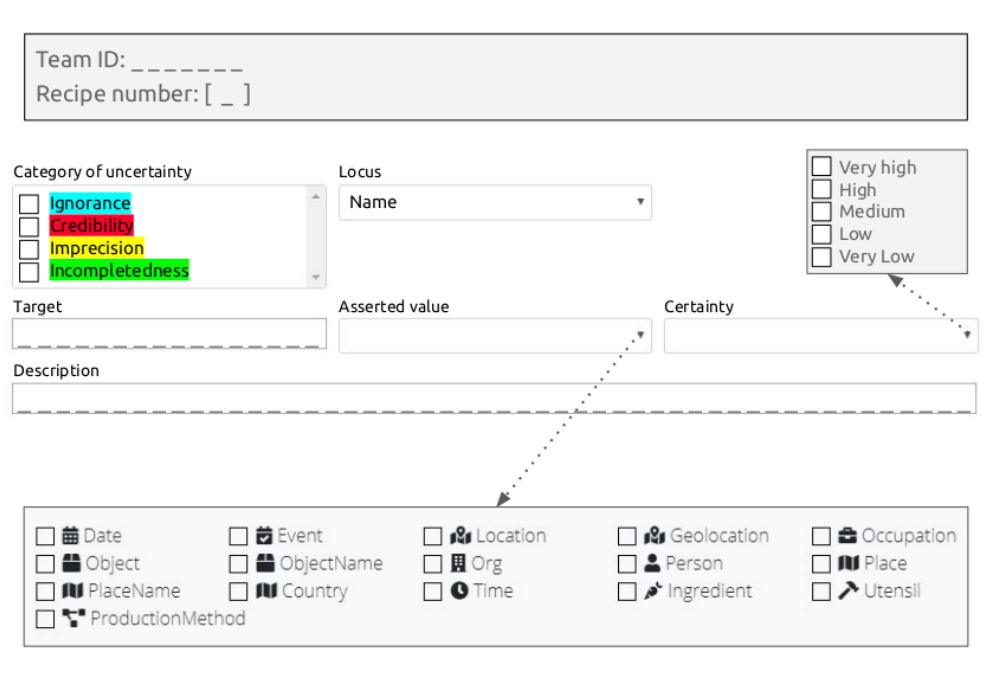
Figure 4. Paper template provided to participants in the second